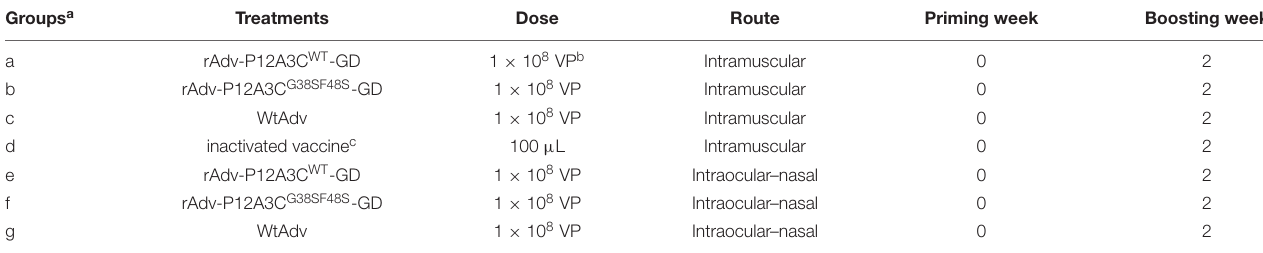
TABLE 1 | Vaccination strategy in the mouse experiment. Groups a